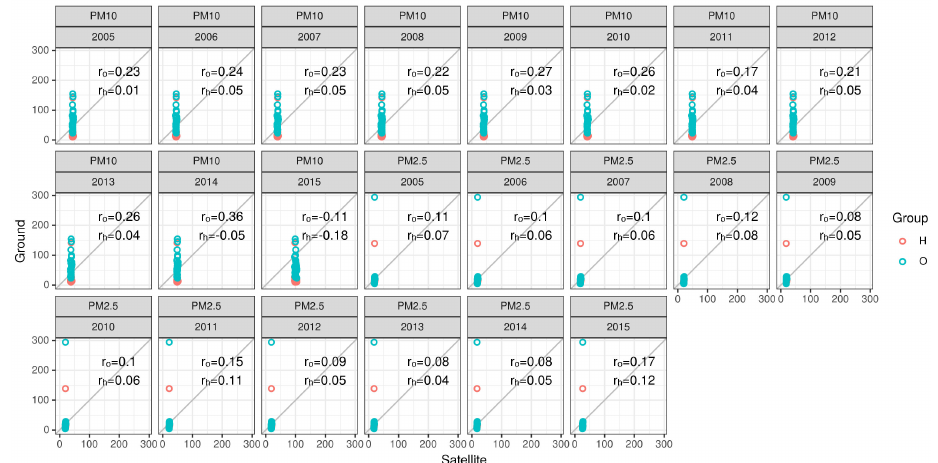
Figure 10. Statistical correlation between ground measurements and satellite-based PM data from September of